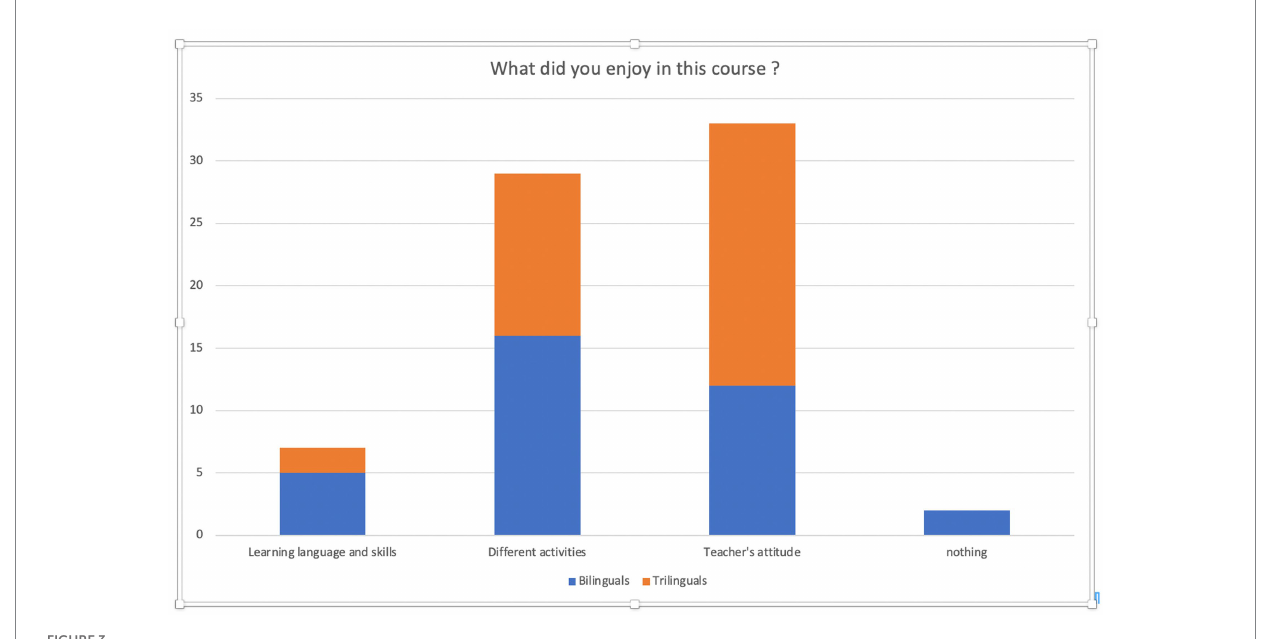
FIGURE 3 Histogram the answers to question 2.